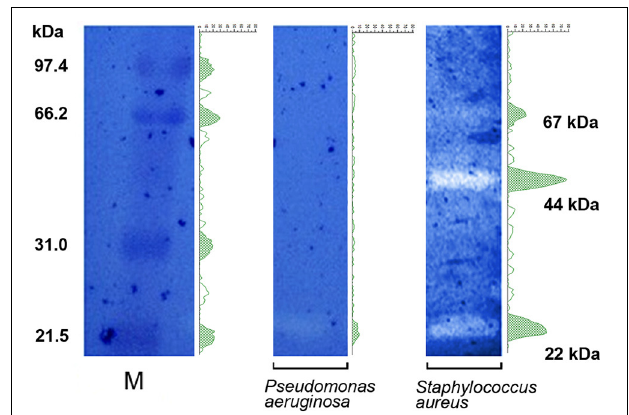
FIGURE 6 | Zymograms. P. aeruginosa e S. aureus were embedded into different polyacrylamide gels and wells were loaded with sonicated B. bacteriovorus . Species-specific lytic bands (white) were visible in correspondence of B. bacteriovorus -derived lytic enzymes, after blue coomassie staining. Densitometry profiles (green) were added to appreciate the differential bacteriolytic activity exerted by B. bacteriovorus on prey cells. M, marker (unstained SDS-PAGE low range standard, Bio-Rad cat